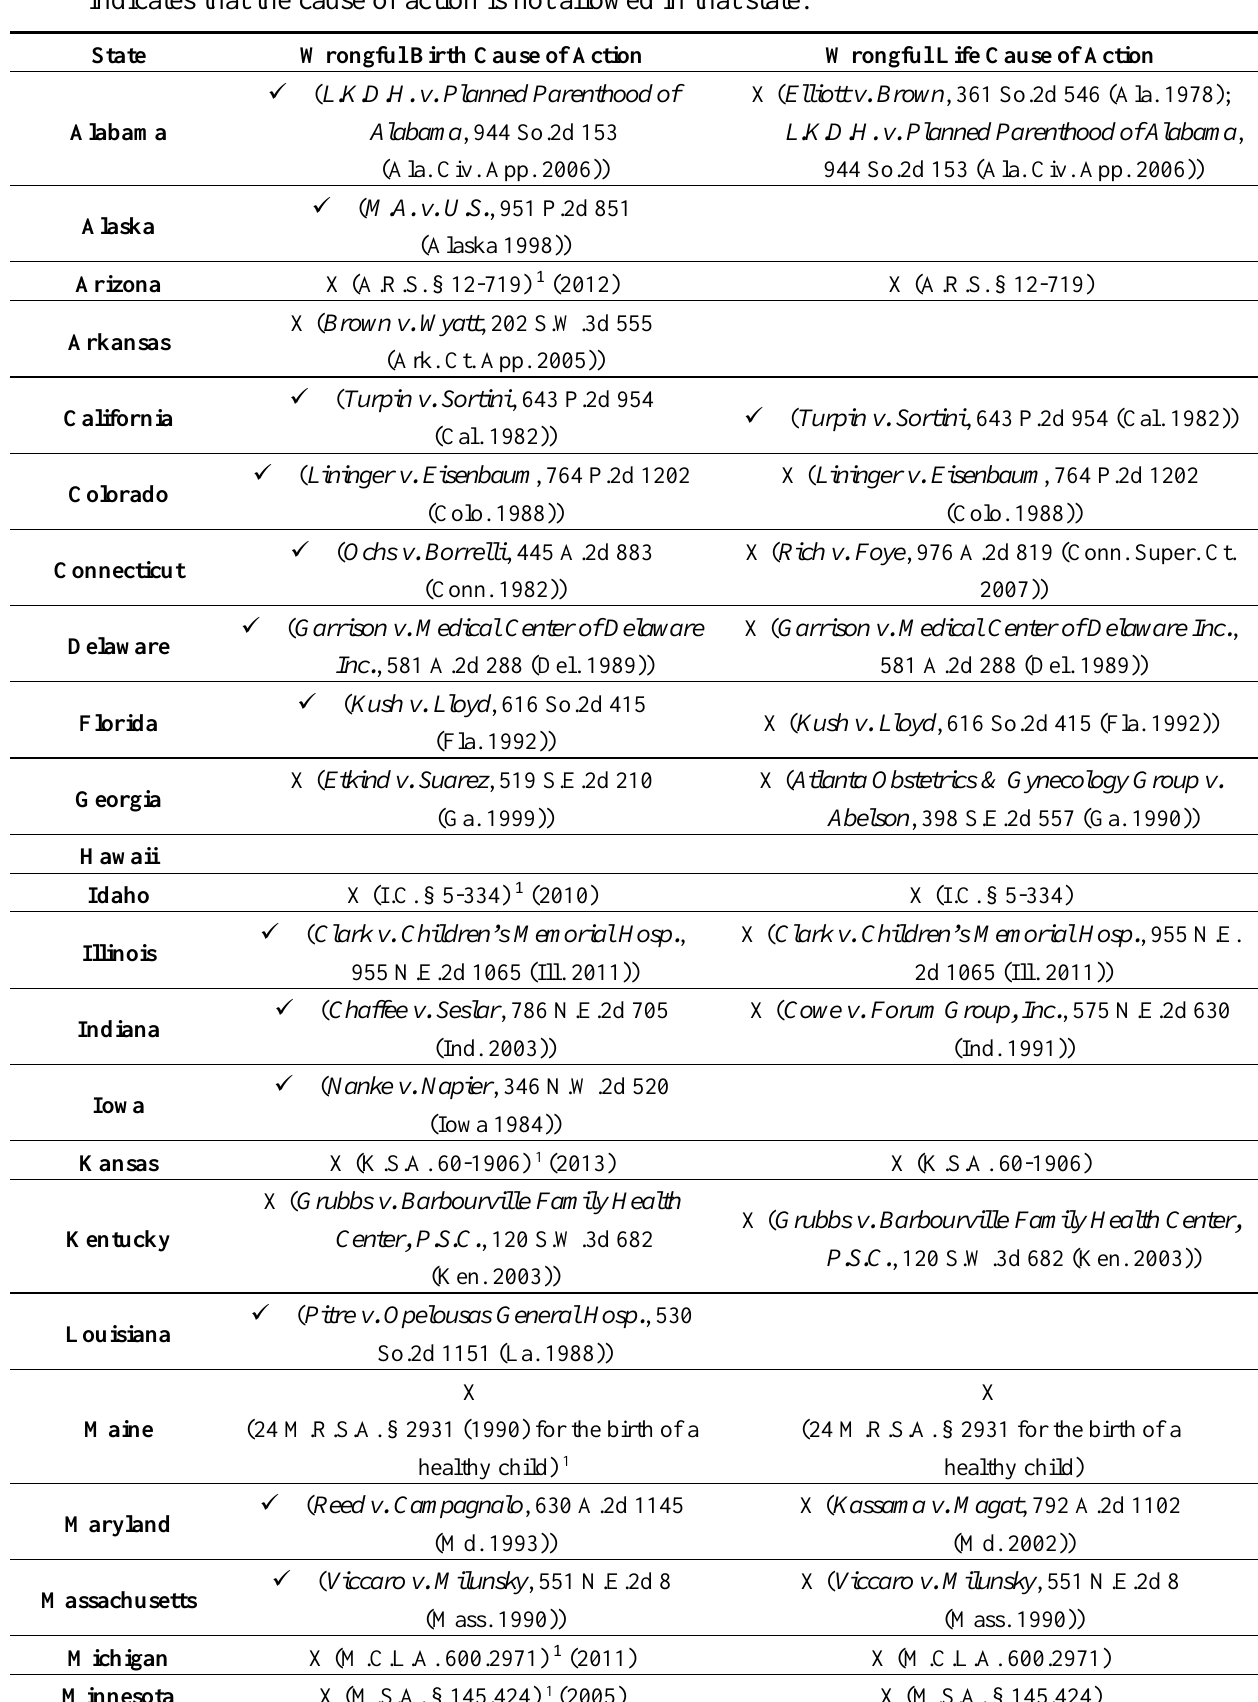
Table 1. Check-marks indicate that the cause of action is allowed in that state; “X” indicates that the cause of action is not allowed in that